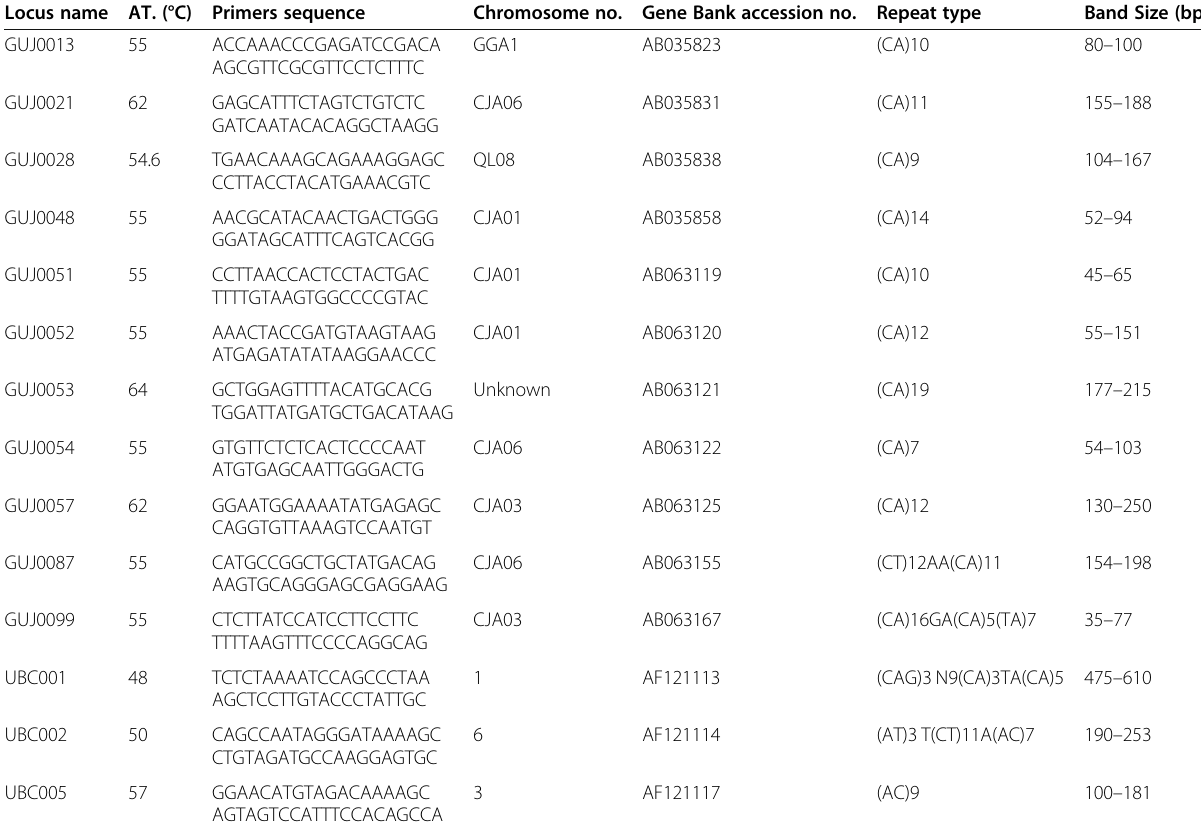
Table 1 Microsatellite loci used, annealing temperatures, primers sequence, gene bank accession numbers, and reported type and size range with jumbo and grey Japanese quail strains Locus name AT. (°C) Primers sequence Chromosome no. Gene Bank accession no. Repeat